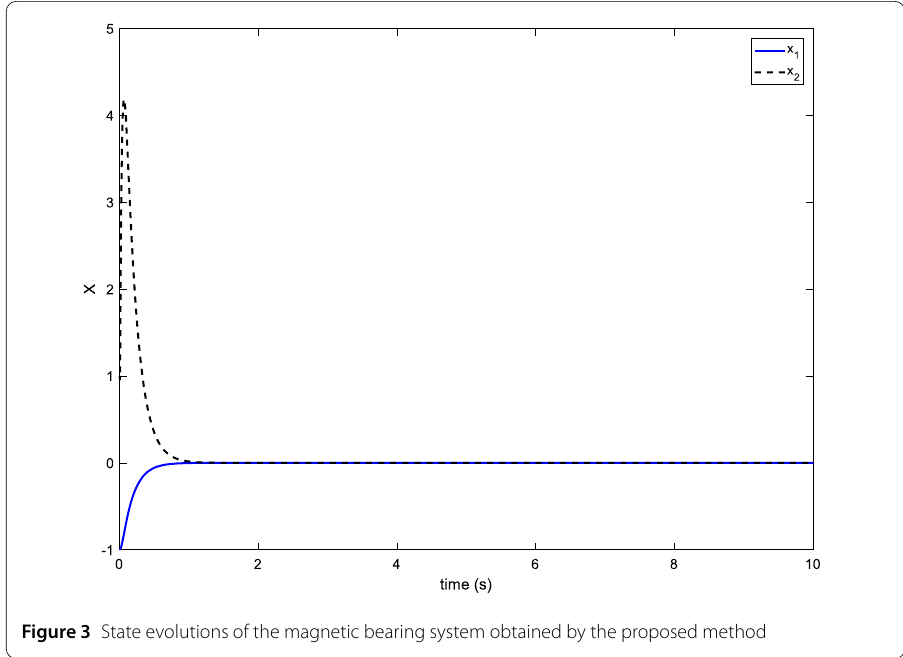
Figure 3 State evolutions of the magnetic bearing system obtained by the proposed method